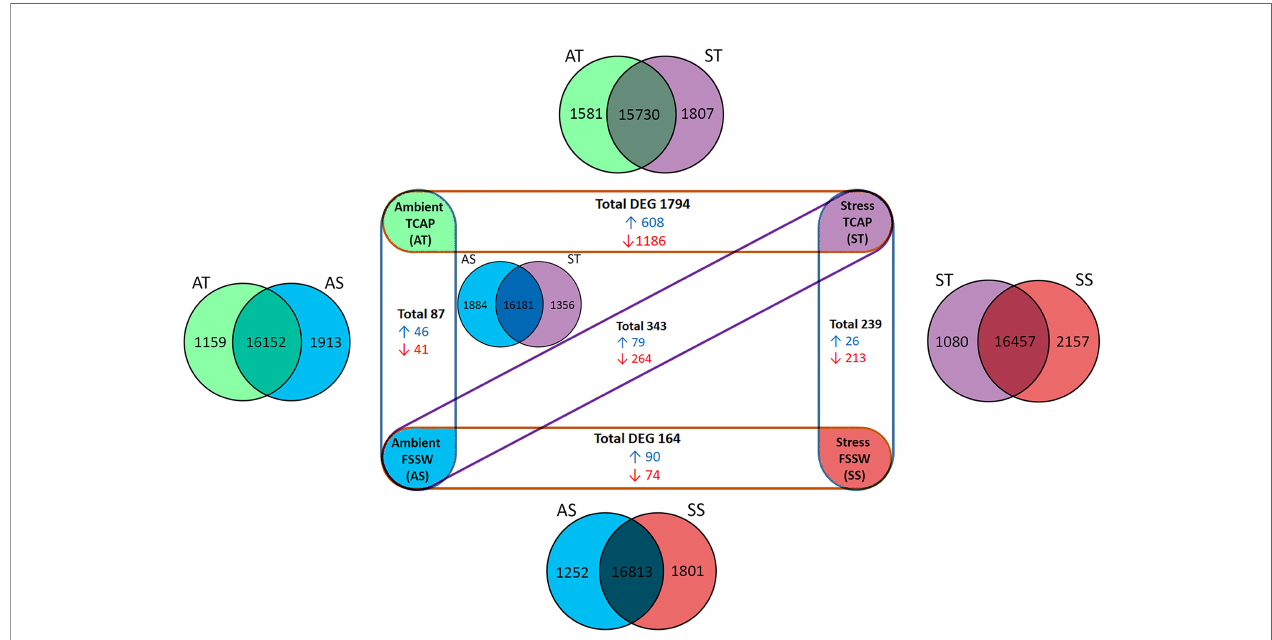
FIGURE 7 | Hemocyte gene expression in response to TCAP/FSSW and ambient/stress treatments (n=4) in different pair-wise comparisons (n=5). Venn diagrams show the total number of expressed genes between different comparisons, including unique and shared expression. Experimental groups show signi fi cant DEG of each pair-wise comparison. Blue: upregulated DEG, red: Down-regulated DEG. FDR ≤ 0.05, log fold change ≥ 1 and ≤